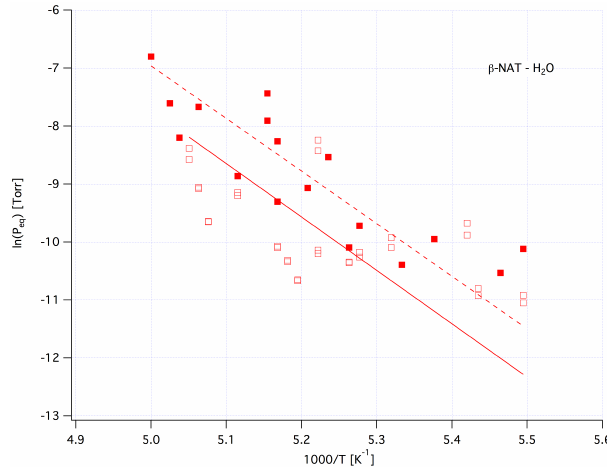
Figure 11. van‘t Hoff plot of P eq (H 2 O) for β -NAT data displayed in Fig. 4c. Full and empty red squares represent results of PV and TO experiments, respectively. The equations for the linear fits may be found in the